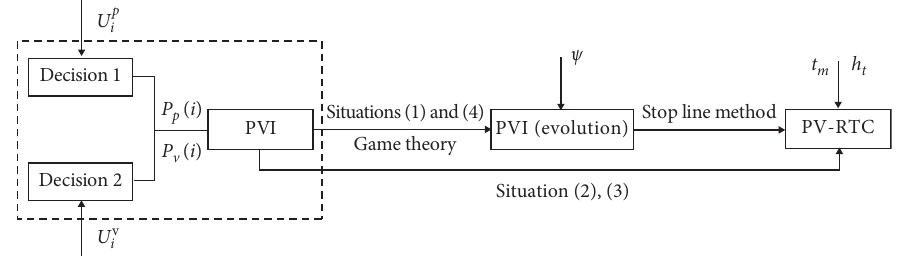
Figure 2: Block diagram of the PV-RTC model. Table 3: Game matrix. Pedestrian/vehicle Pass Yield